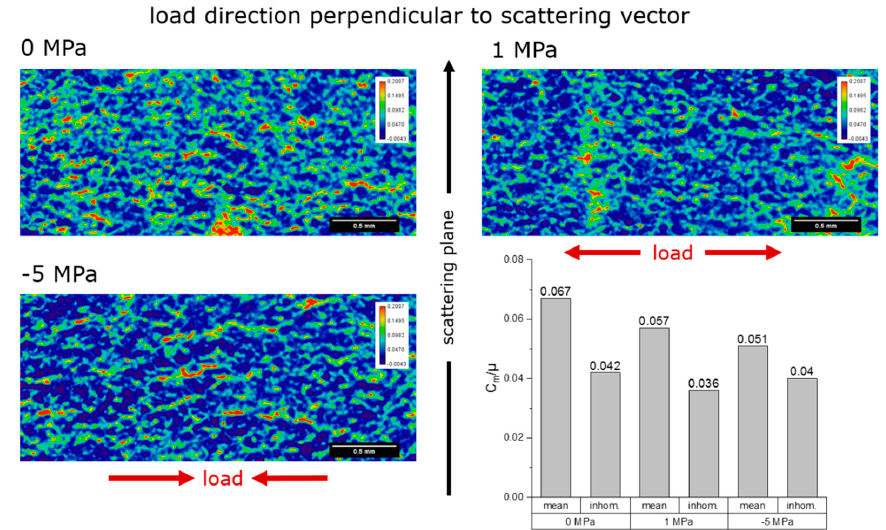
Figure 7. Visualization of the local values of the relative specific refraction value C m / µ of the specimen as 2D color-coded images. The load direction of the specimen was perpendicular to the scattering plane of the analyzer crystal. Top left: Unloaded, top right: 1 MPa tensile loaded and bottom left: 5 MPa compression loaded. Bottom right: The integral values of the relative specific surface for all specimens are shown as bar graphs. The small bars represent the inhomogeneity of the C m / µ values across the measured area of the specimen.